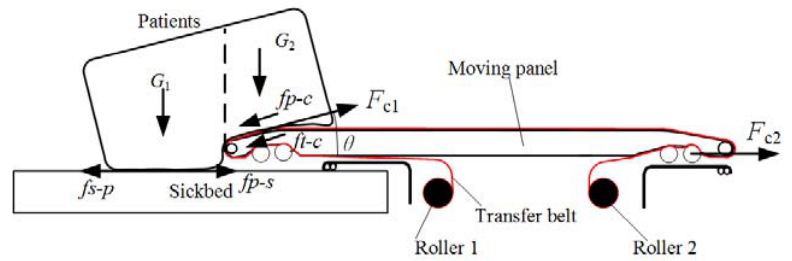
Figure 8. Driving force analysis of the transfer belt.